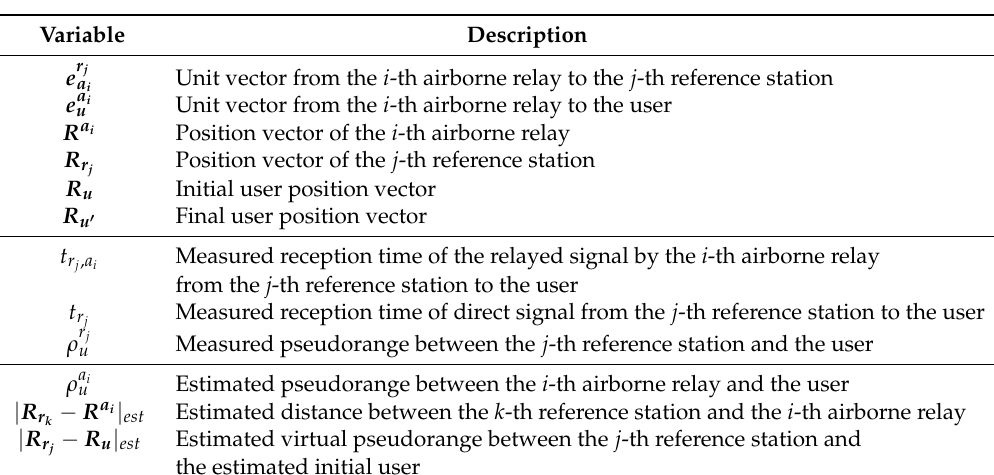
Table 1. Main notations for the mathematical